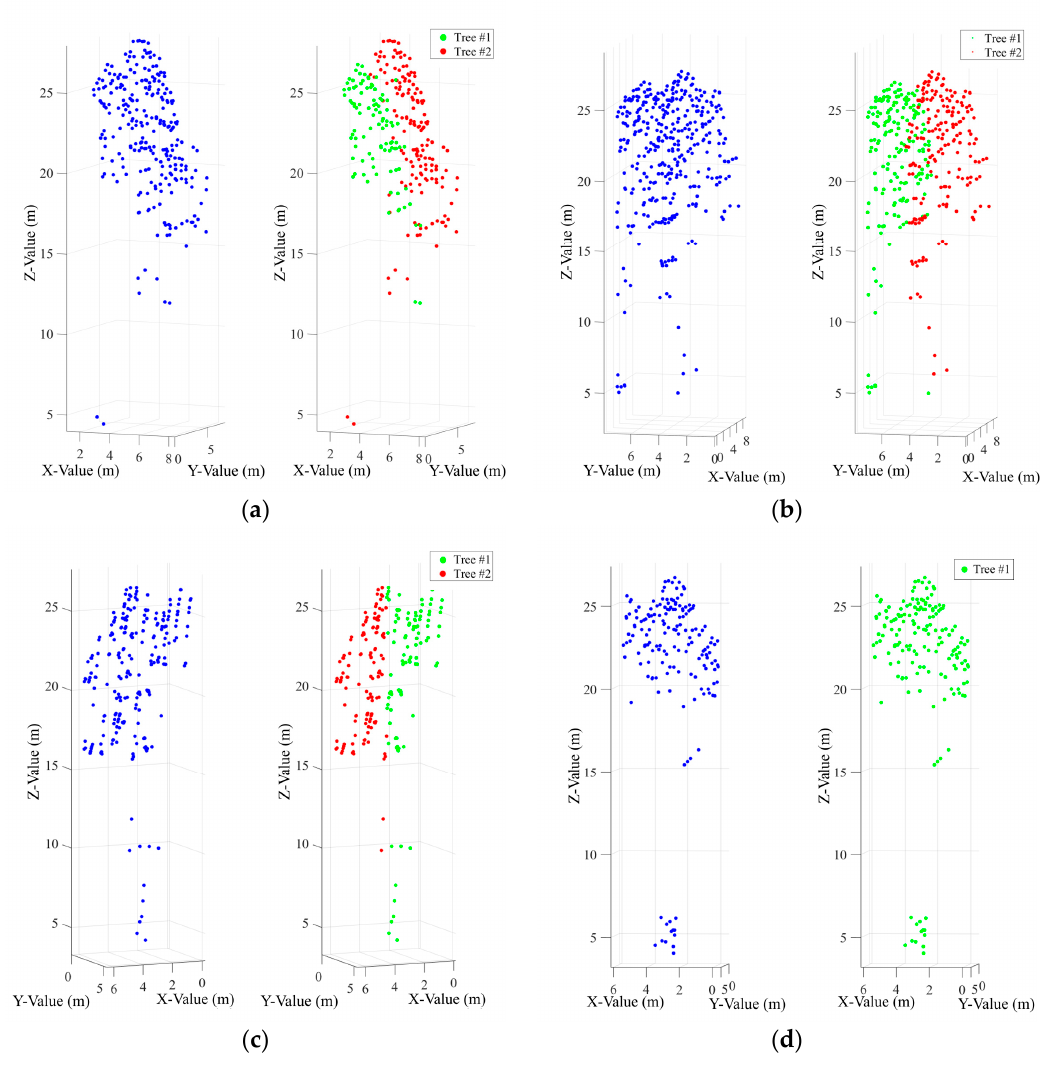
Figure 11. Examples of refinement results using morphology segmentation: ( a ) the segment contained two canopies with a large tree height difference, ( b ) the segment contained two canopies with relatively equal heights, ( c ) the refinement segment contained one over-segmentation crown and one complete crown, and ( d ) the unchanged segment contained one over-segmentation crown and one complete crown.